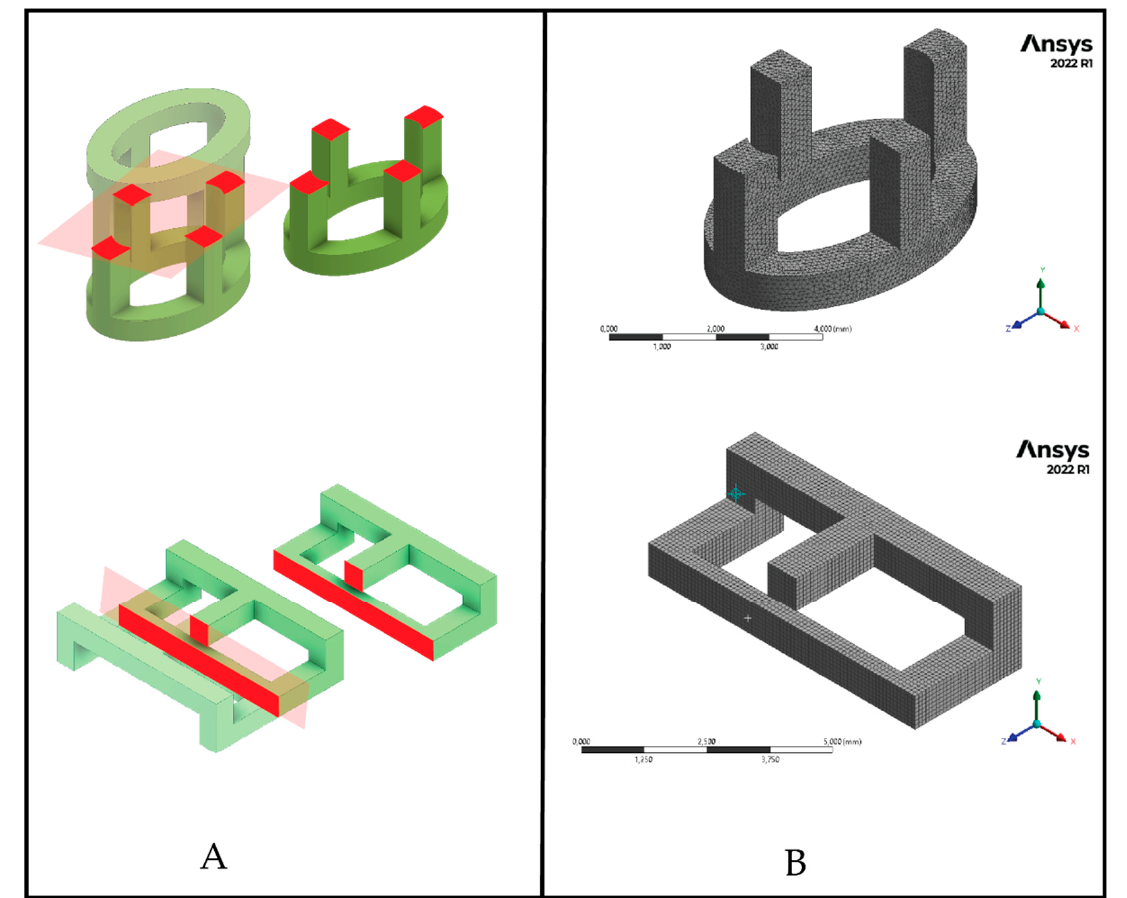
Figure 3. Geometric simplification of the cylindrical and prismatic elements ( A ) and meshing of the simplified models ( B ).